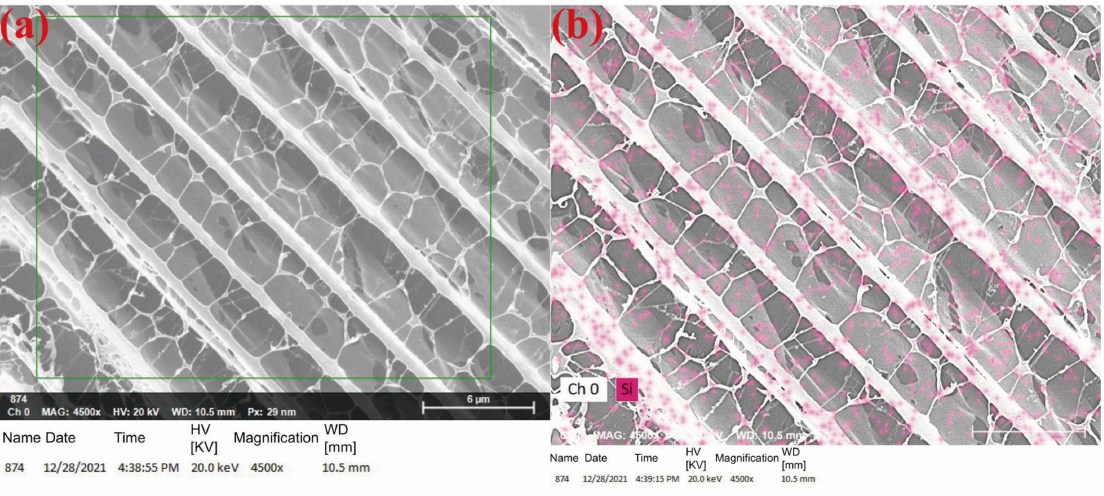
Figure 8. Distribution of nano-SiO 2 in polymer solution: ( a ) scanning region; ( b ) silicon ele- ment